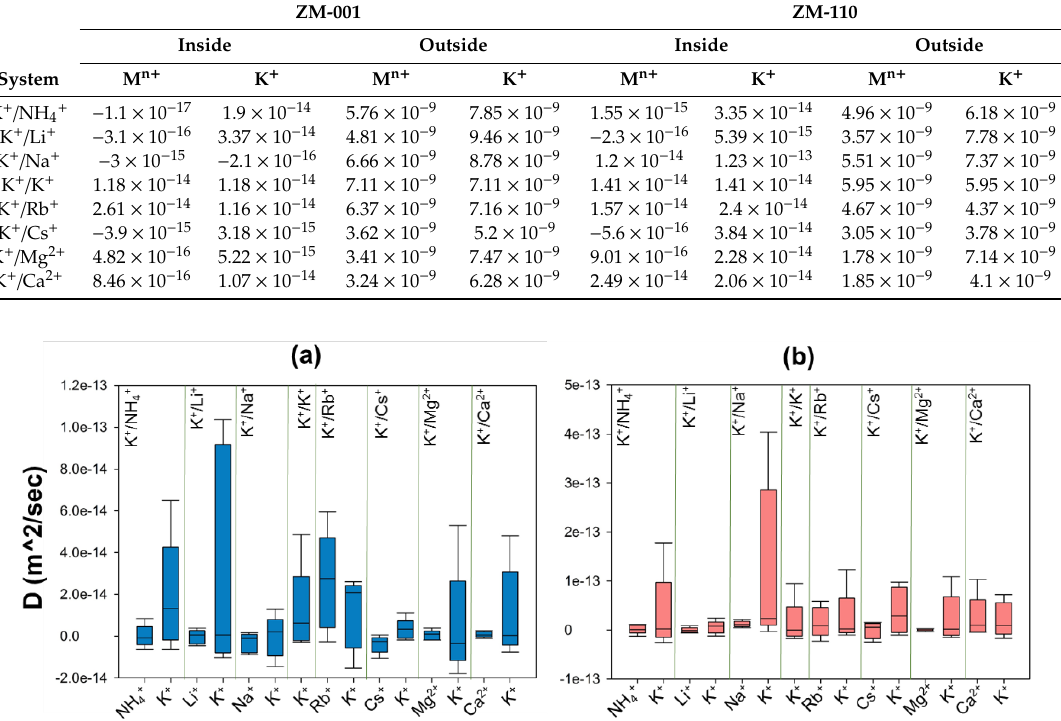
Figure 7. Illustrations of SI and SII sites for extra-framework K in zeolite N supercells along ( a ) [001] and ( b ) [110] crystallographic directions. The 8-membered ring pore openings in each channel direction are highlighted with green colour. The black dashed lines indicate the interaction of potassium cations in sites SI and SII with framework oxygen atoms. Atoms are coloured as silicon = yellow, aluminium = pink, oxygen = red, potassium = purple and chloride = light green.